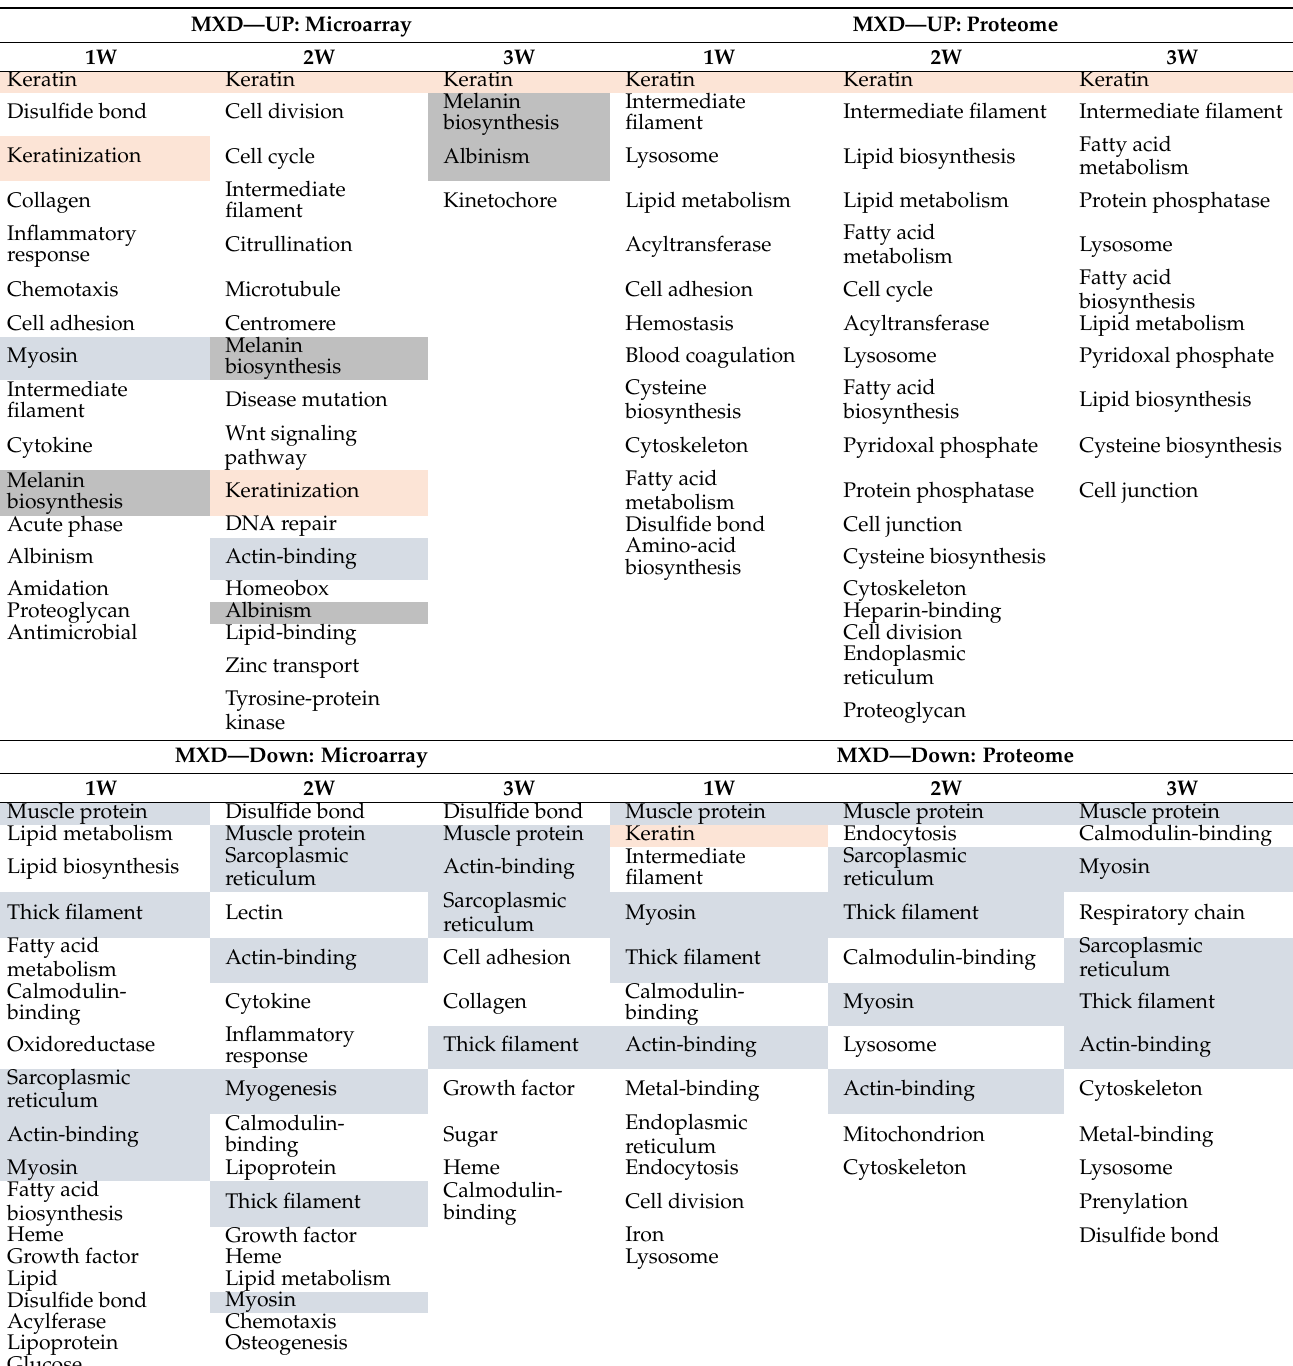
Table 5. A biofunctional categorization and pathway of the identified genes and proteins in the MXD group 1 week, 2 weeks, and 3 weeks after treatment. Both the up- and down-regulated terms for genes and proteins were displayed together for comparison. DNA microarray and proteomics and DAVID analyses were performed as described in the Section